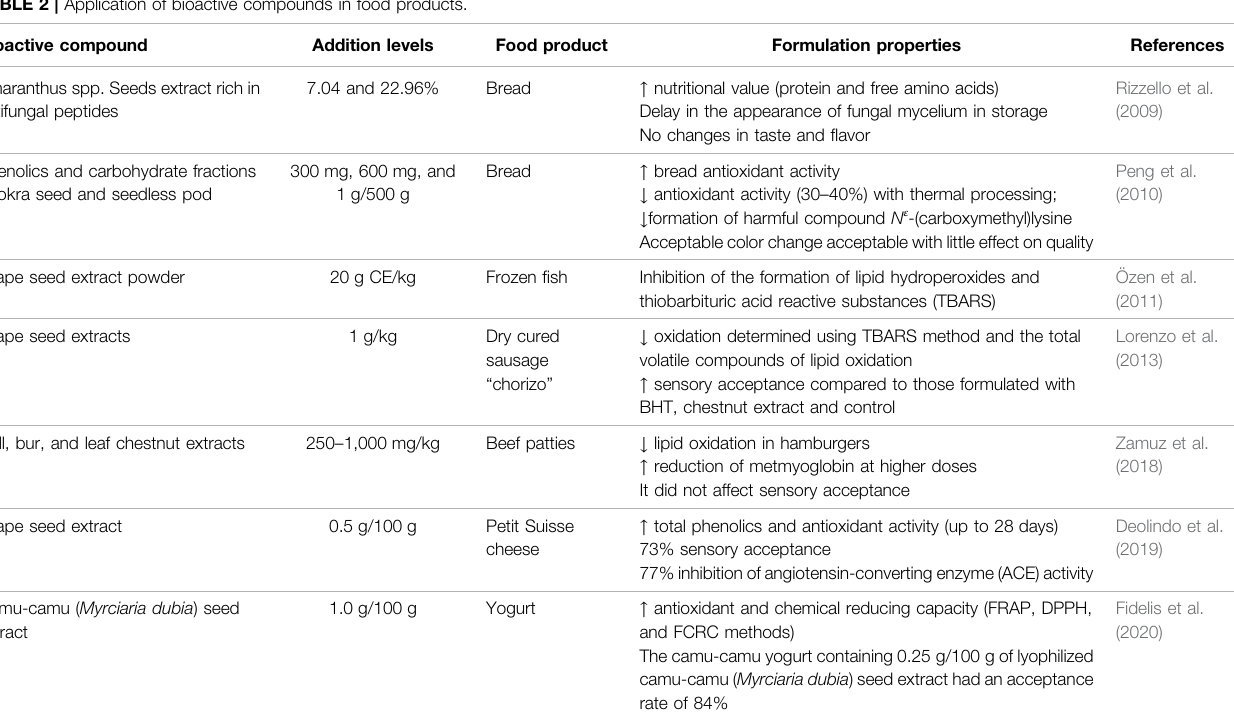
TABLE 2 | Application of bioactive compounds in food